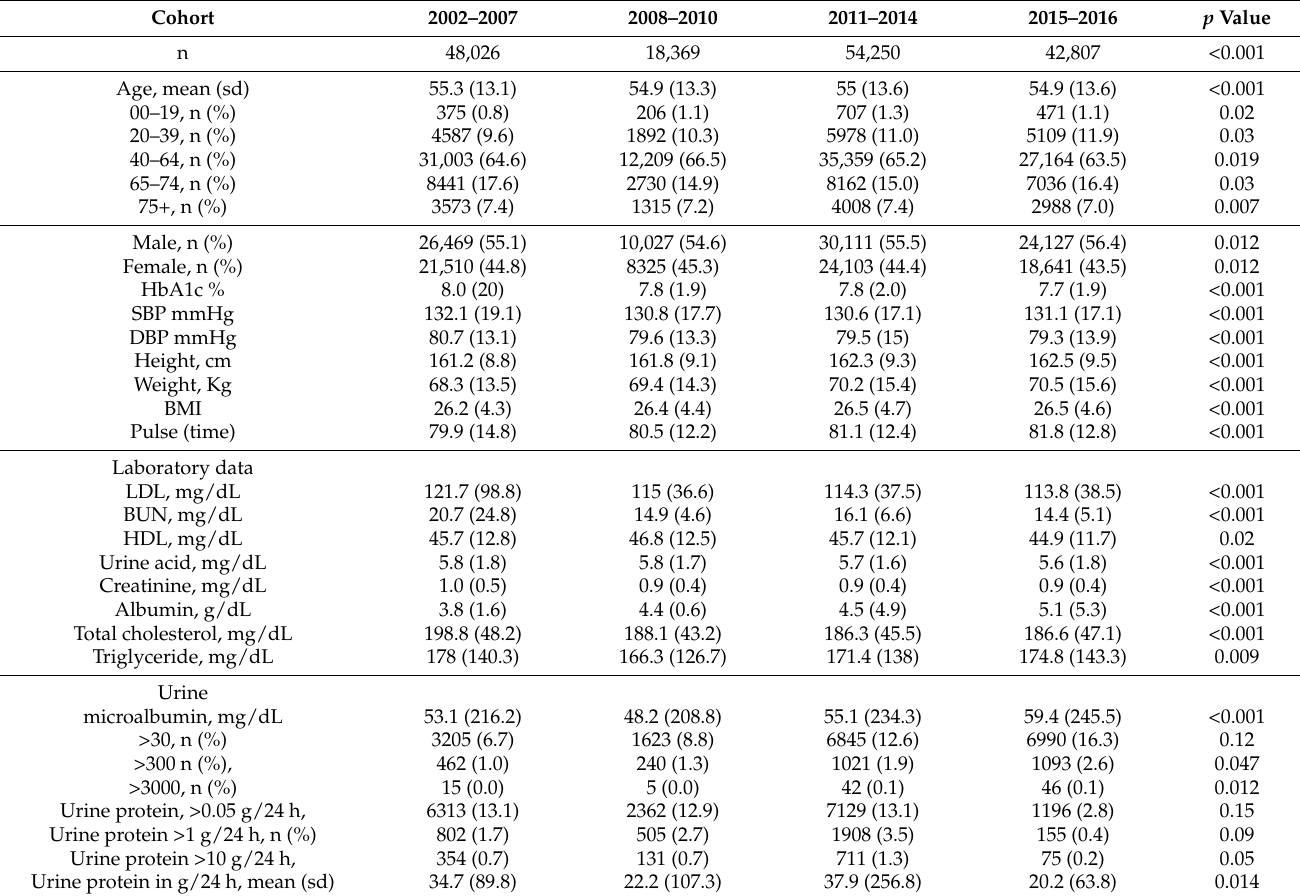
Figure 3. HbA1c values change with respect to time at different ages where the HbA1c value is a function of age ‘ a ’ and duration ‘ t ’, where θ , ϕ , and ψ are coefficients of this regression function. Table 1. The baseline of the new diagnosis of diabetic subjects in the program of diabetic pay for performance in 2002–2016. Data represented as mean and SD, and count and proportion for continuous and categorical variables,